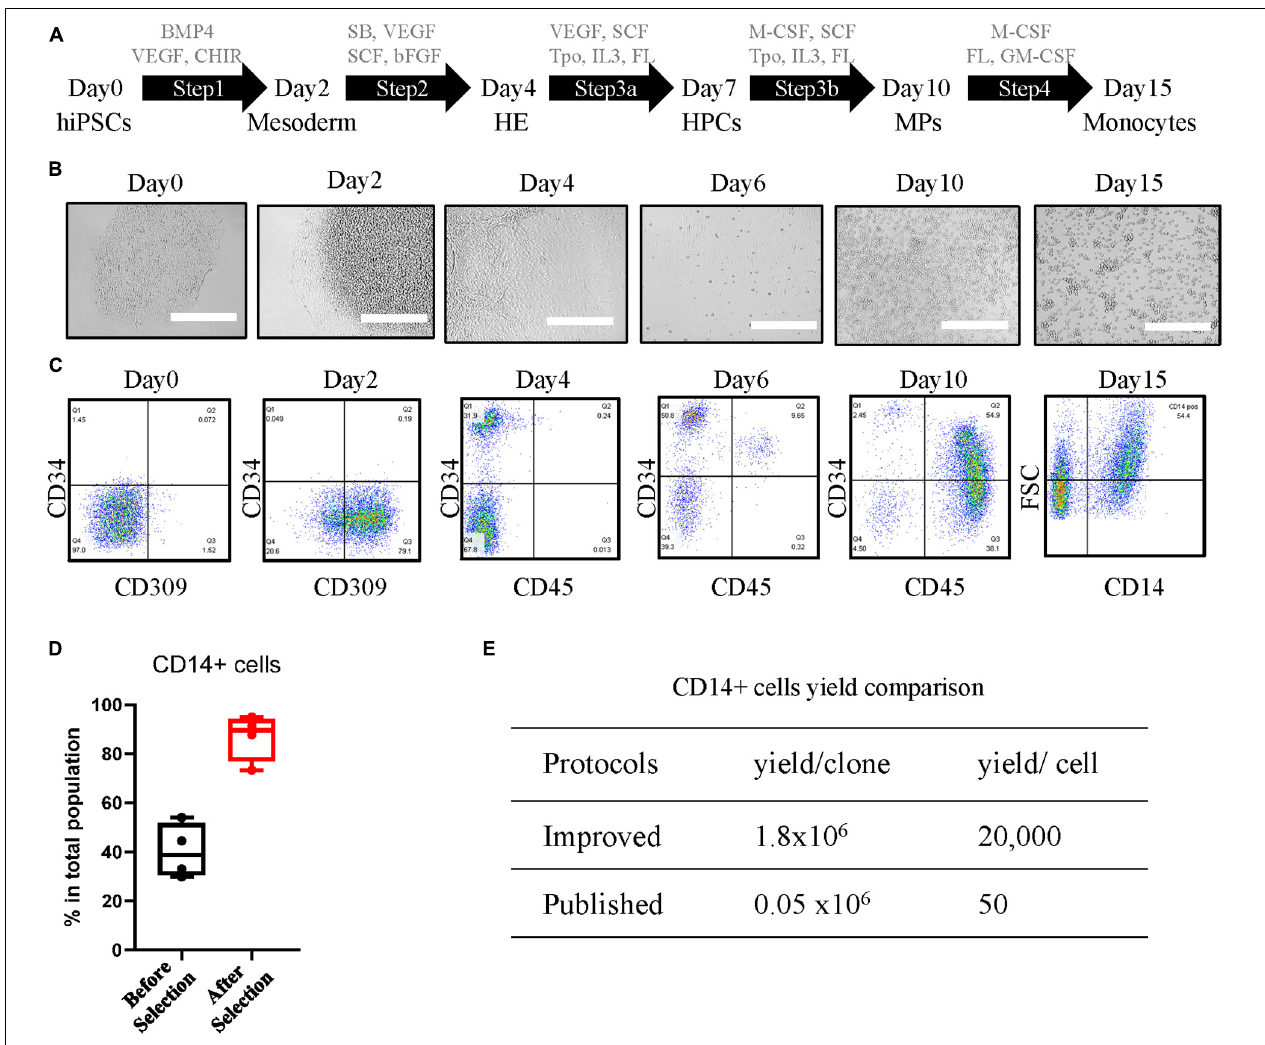
FIGURE 1 | Differentiation and characterization of human induced pluripotent stem cell (hiPSC)-derived CD14-positive monocytes. (A) Differentiation schematic overview indicating the cytokines, chemokines, and chemicals for each step: undifferentiated hiPSCs, mesoderm, hemogenic endothelium (HE), hematopoietic progenitor cells (HPCs), myeloid progenitors (MPs), and monocytes. The concentration of the compounds used is shown in Experimental Procedures section. (B) Representative images of cellular morphology during differentiation of each step at Day 0, Day 2, Day 4, Day 6, Day 10, and Day 15. Scale bar represents 400 µ m. (C) Characterization of differentiation-specific markers at each stage by fluorescence-activated cell sorting (FACS). (D) Yield of CD14-positive cells of the total population before and 2 days after CD14 bead selection. (E) Yield comparison of CD14 + cells between improved protocols and other published